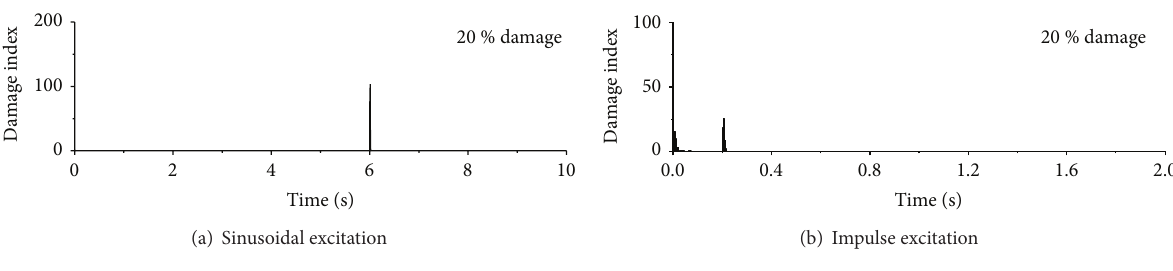
Figure 10: Damage detection using db4